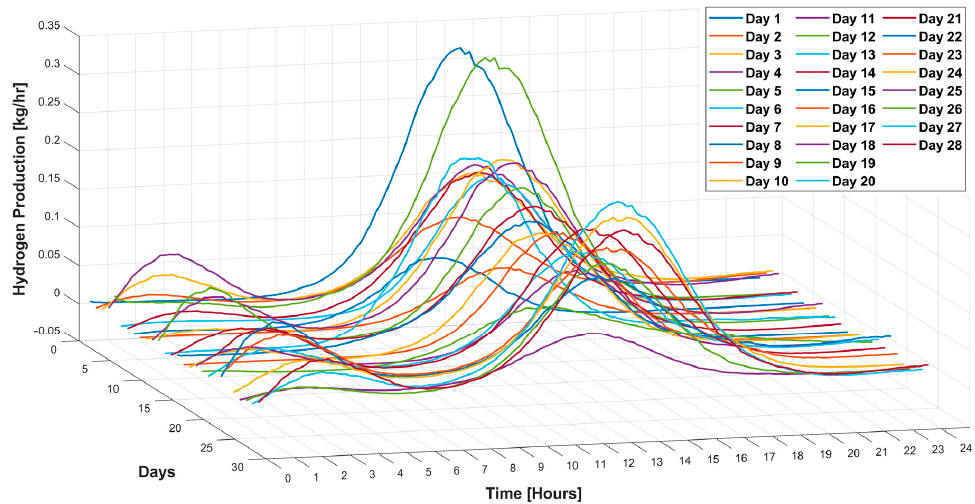
Figure 11. Estimated rate of Hydrogen production per day.